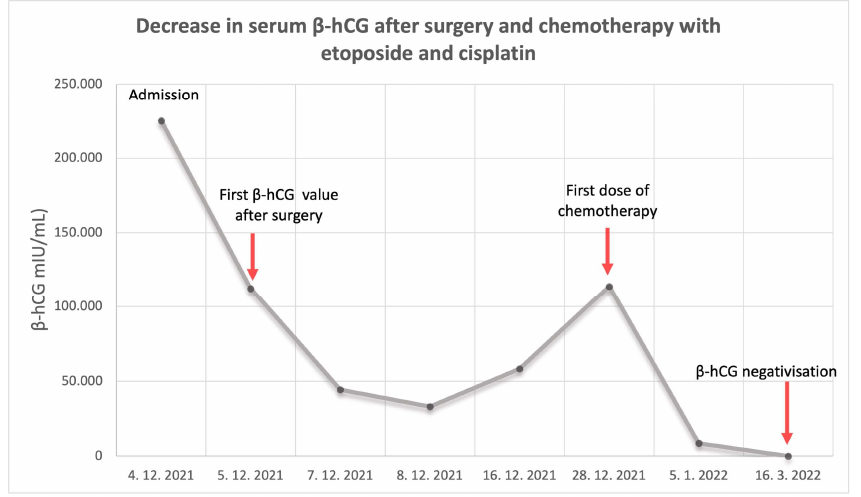
Figure 2. Decrease in serum β-hCG levels from admission to negativization. Biochemical follow-up was performed during the initial treatment follow as well as after systemic therapy treatment.